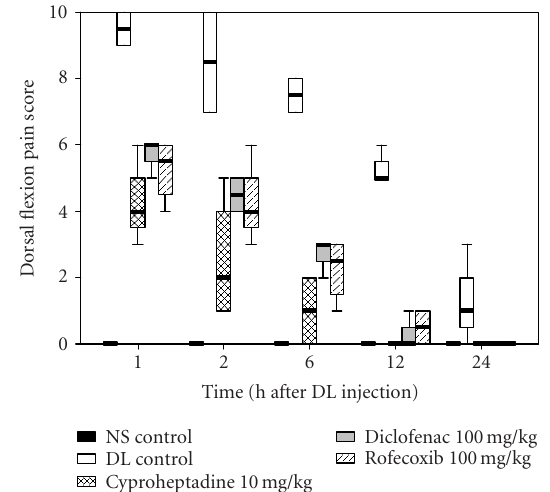
Figure 3. Antihyperalgesic e ff ect of various drugs on DL- induced inflammatory hyperalgesia. Edema was induced by in- jecting 0 . 1mL of 1% solution of DL into subplantar surface of right hind paw. The drugs were administered orally 1hour be- fore injecting DL. Dorsal flexion pain score was recorded at 1, 2, 6, 12, and 24hours ( n = 6). The data is illustrated as box plots where bold line represents median values, boxes represent interquartile ranges (25th and 75th percentiles), and whiskers represent extreme values.